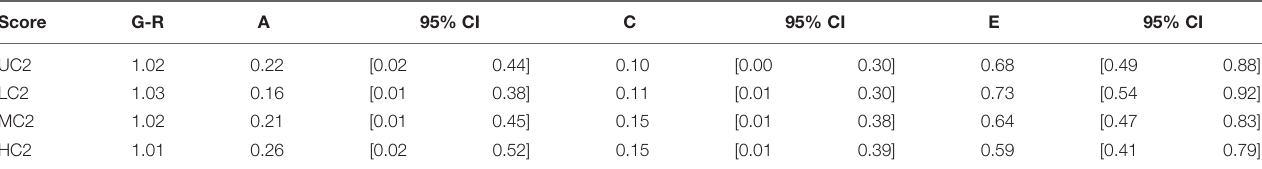
TABLE 6 | Genetic and environmental factor estimations in Bayesian ACE models in Study 2 with non-informative